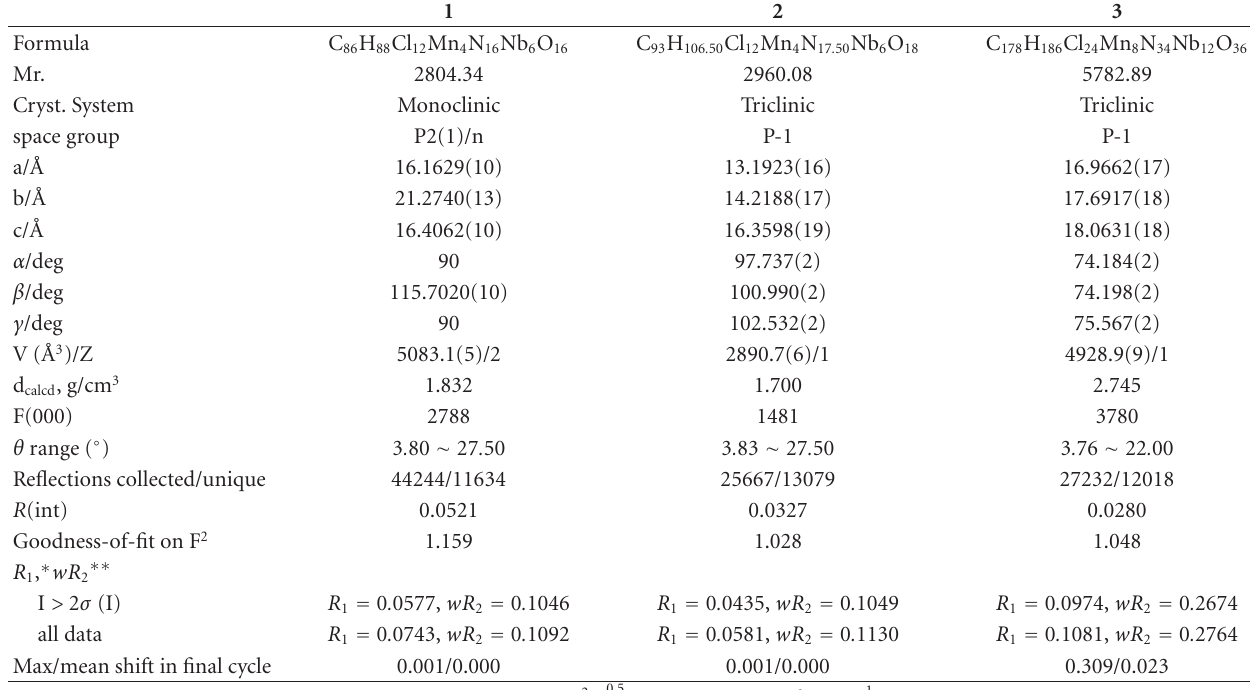
Table 2: Crystal data and structure refinement for the